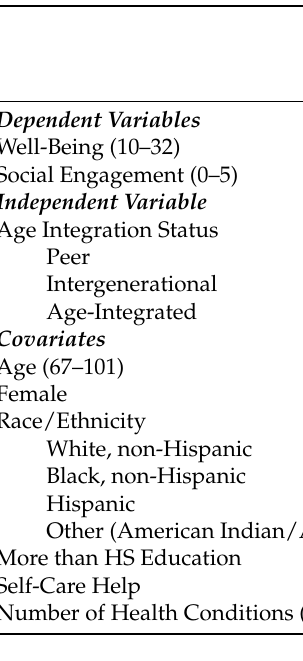
Table 1. Weighted Descriptive